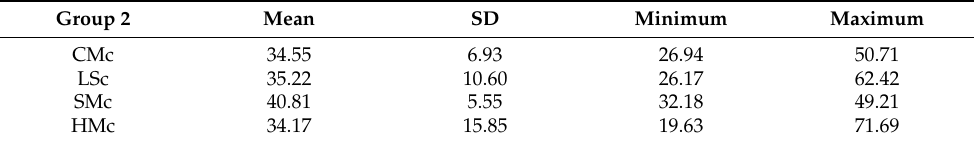
Table 3. Mean, standard deviation (SD), minimum and maximum ( µ m) marginal discrepancies values in frameworks with cantilever